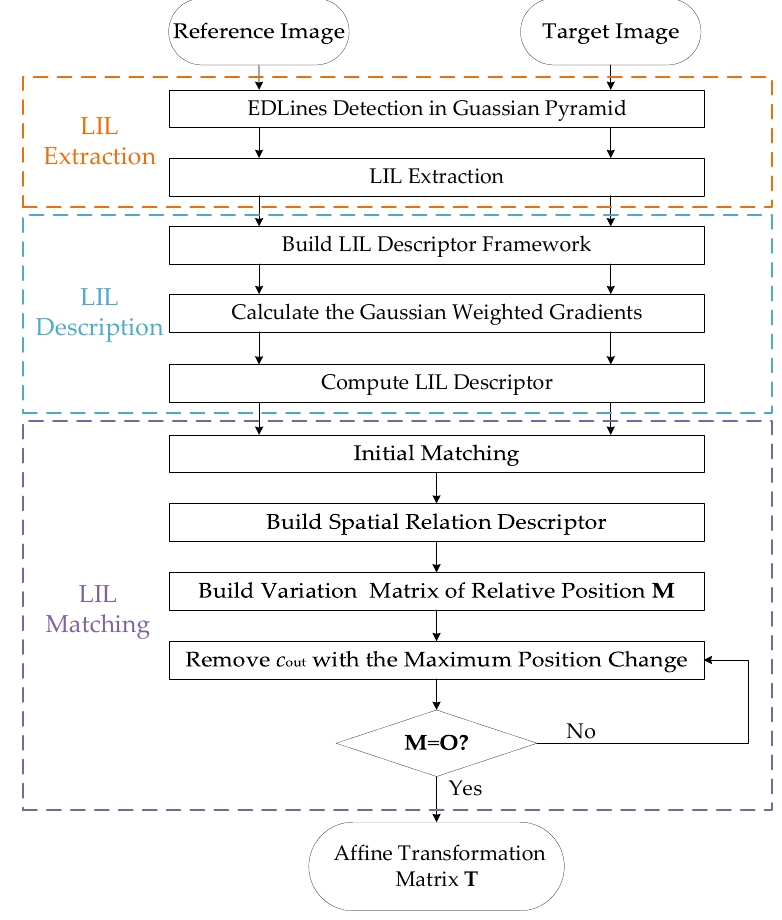
Figure 1. Flowchart of the LIL algorithm.